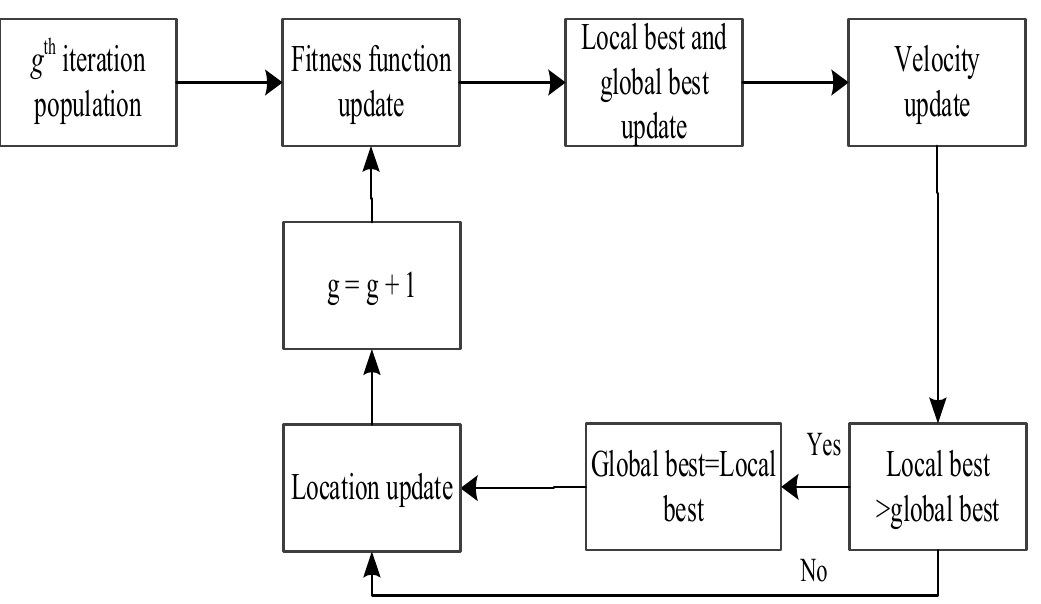
Figure 1. The flow chart of the particle swarm optimization (PSO) algorithm.